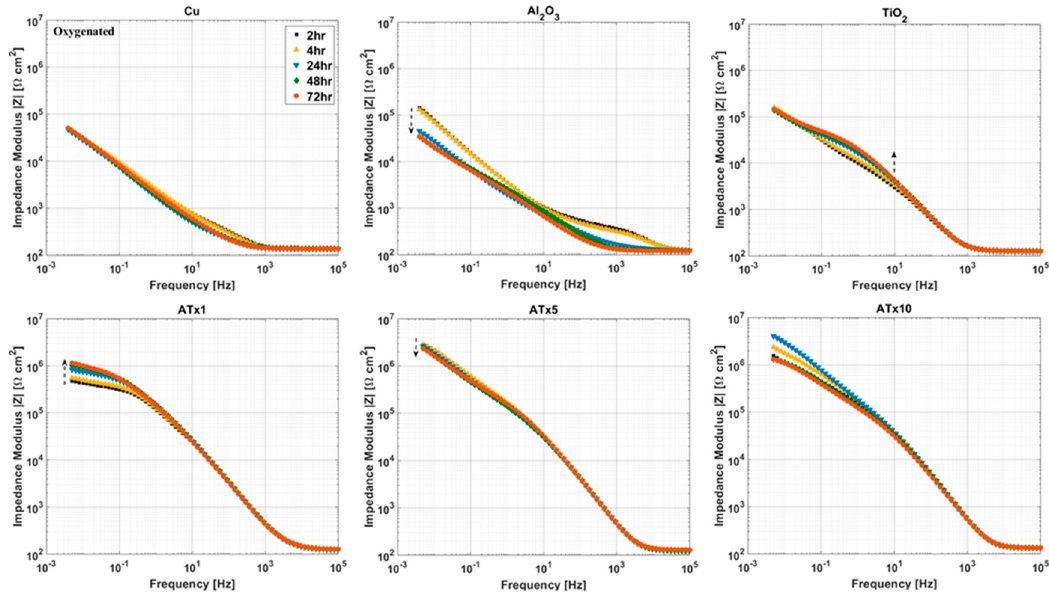
Figure 9. Impedance modulus versus frequency at selected immersion times over 72-h immersion in oxygenated 0.1 M NaCl. Frequency range is 100 kHz to 5 mHz and sample type is given above each plot. Dashed arrows indicate increasing immersion time. Refer to Table 1 for sample descriptions.